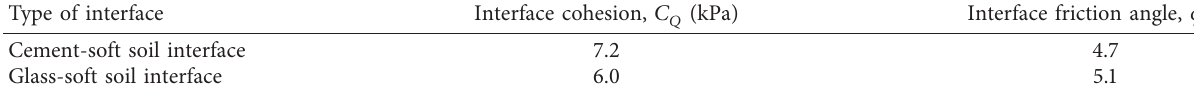
Table 2: Shear strength parameters of particle-soft soil interface frictional intensity.